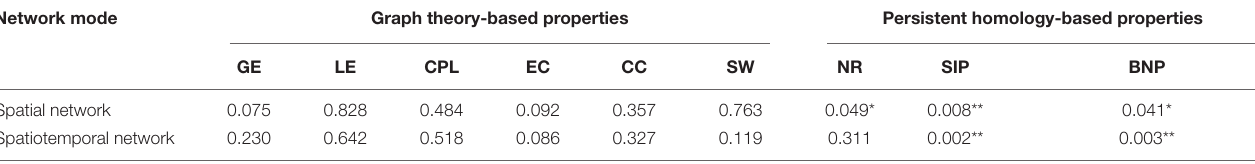
TABLE 2 | Statistical p -values of different network properties between Alzheimer’s disease (AD) and normal control (NC) groups in automated anatomical labeling (AAL). Network mode Graph theory-based properties